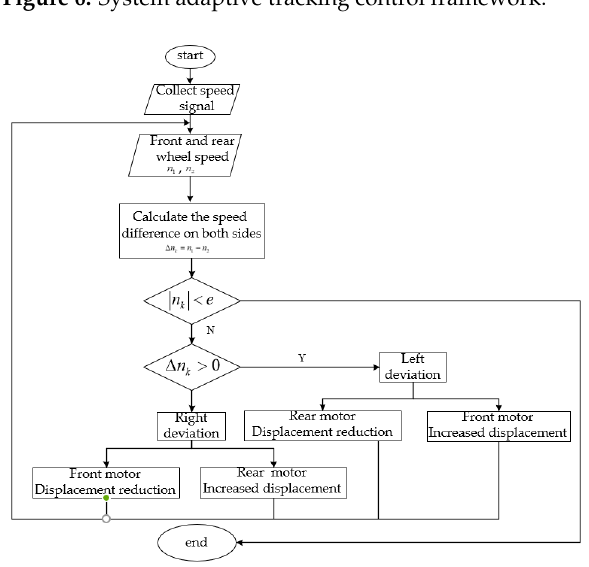
Figure 7. Flow chart of motor synchronous driving control.